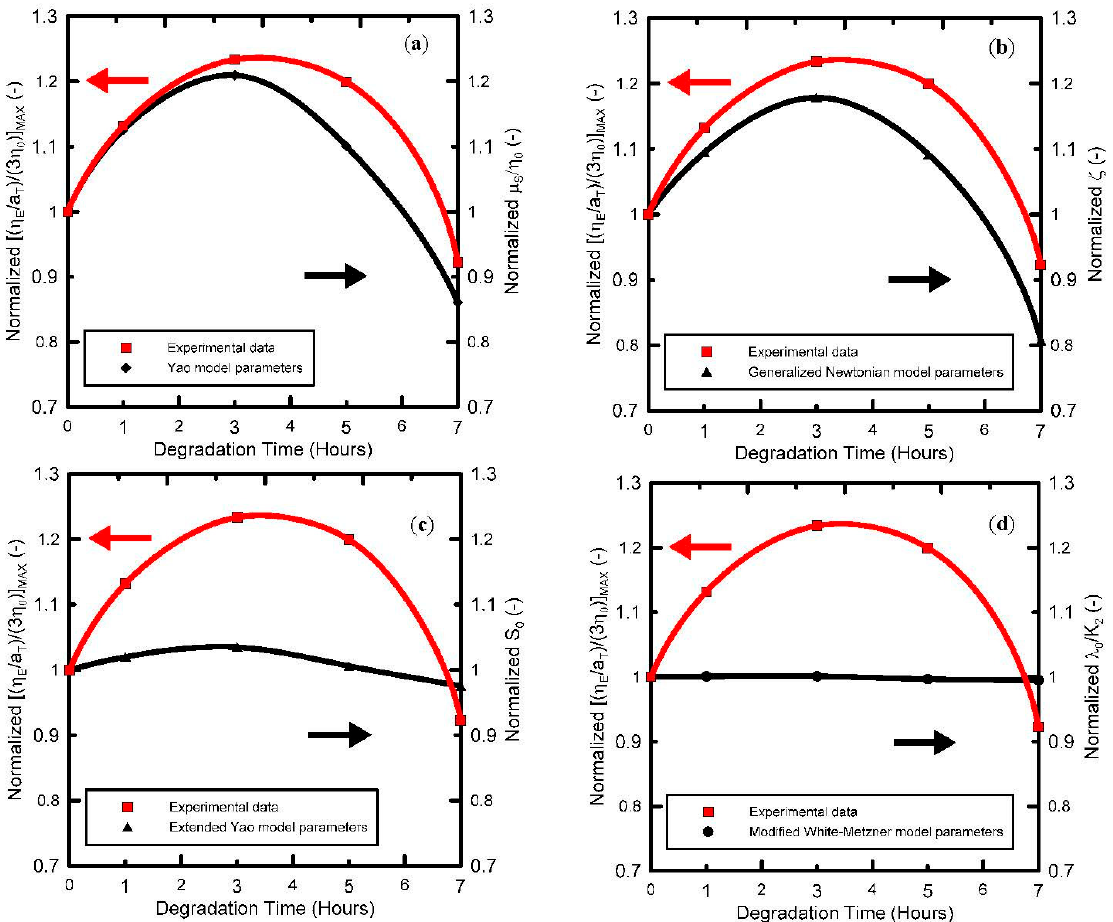
Figure 11. Correlation between normalized uniaxial extensional viscosity and normalized model parameters for branched PP at 180 °C for different degradation times. ( a ) Yao model; ( b ) Generalized Newtonian model; ( c ) Extended Yao model; ( d ) Modified White-Metzner model.